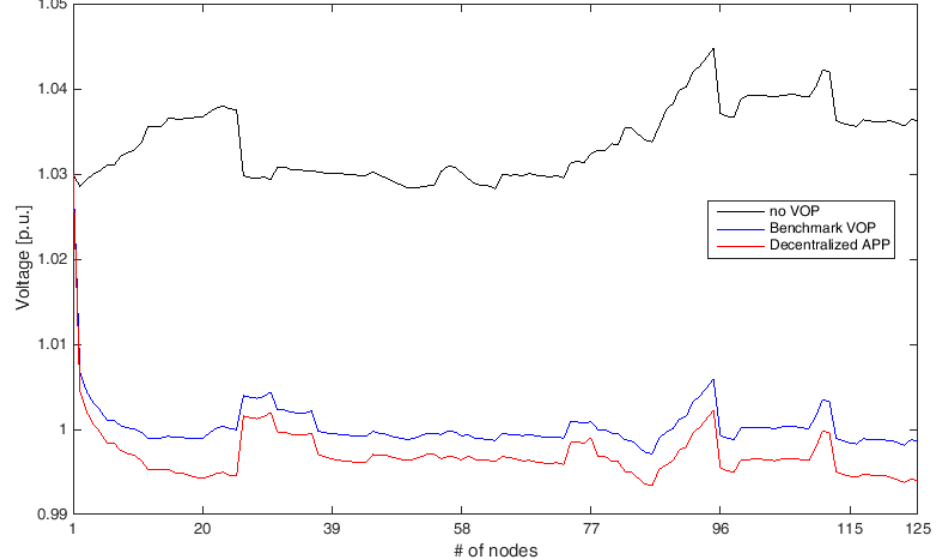
Figure 16. The network voltage profile for the no VOP , Benchmark VOP, and Decentralized APP in Case 2 .